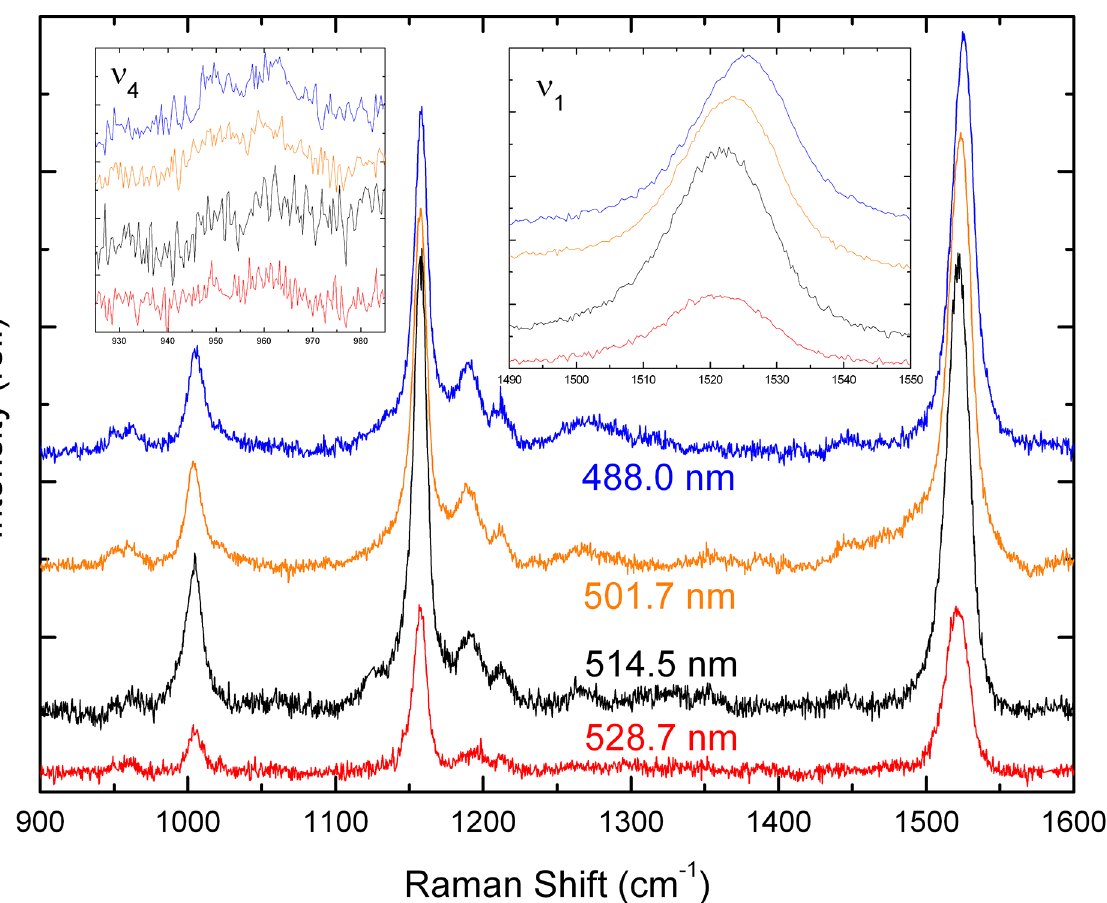
Fig 3. Resonance Raman spectra of human macula. Room temperature spectra (900 – 1600 cm -1 ) are shown for ex vivo human retina in the macular region, excited at 488.0, 501.7, 514.5 & 528.7 nm (blue, olive, black, red respectively). Details of the ν 1 & ν 4 regions are shown in the insets. Representative spectra are shown for a single macula, but were the same for all 8 subjects used in this study.